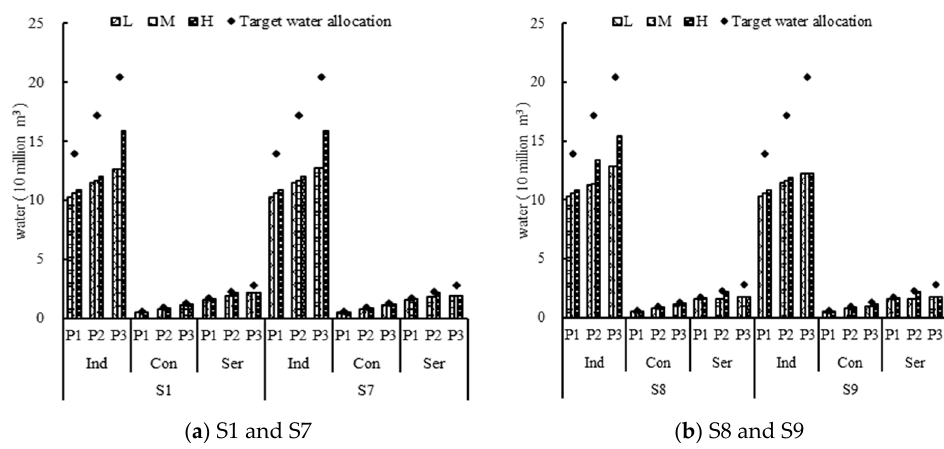
Figure 10. The overall water allocation of industry, construction and services in Bayan Nur City under four scenarios: S1, S7, S8 and S9 (Ind: industry, Con: construction, Ser: services).